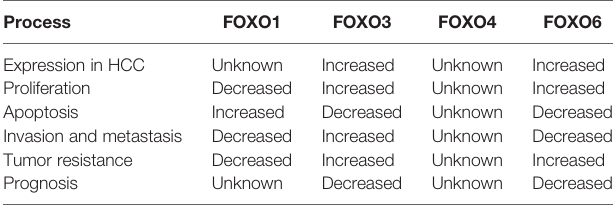
FOXO, forkhead box O protein; HCC, hepatocellular